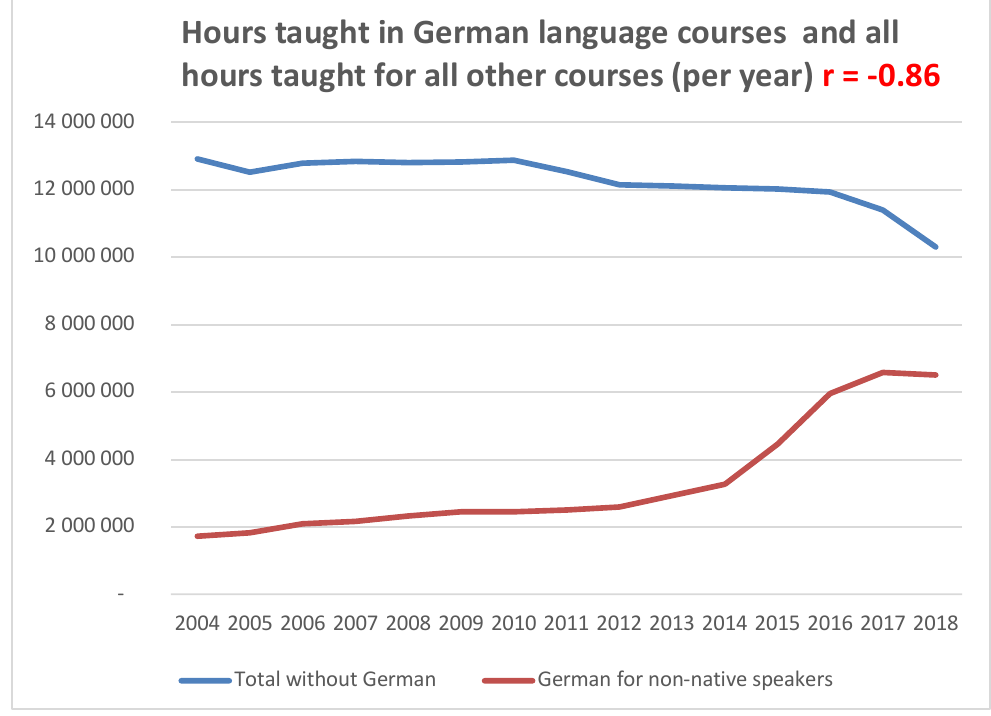
Figure 3. Hours taught in German for migrants, and hours taught in all of the other program areas per year. (Source: dvv-Statistik. Data processing is my